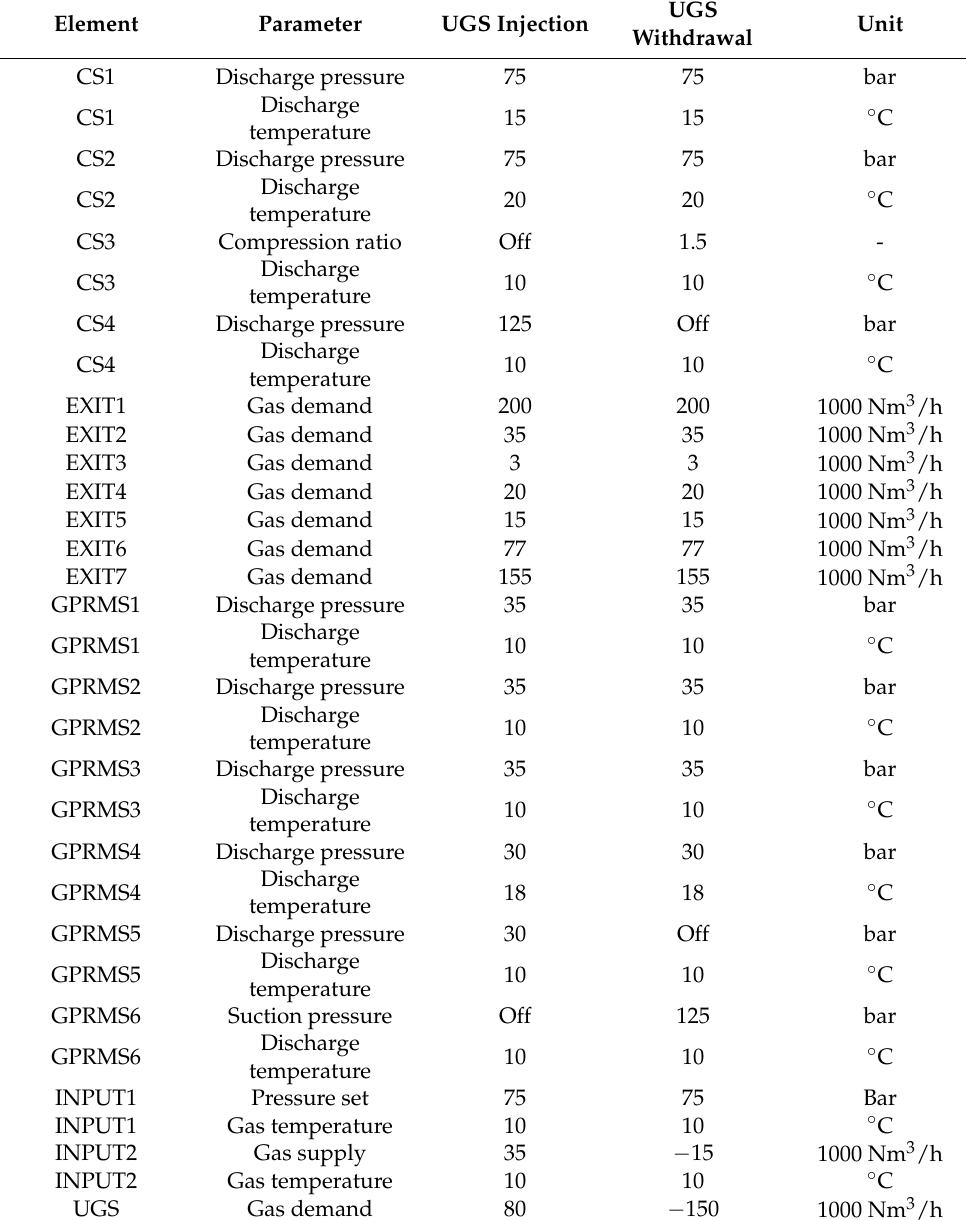
Table 4. Simulation